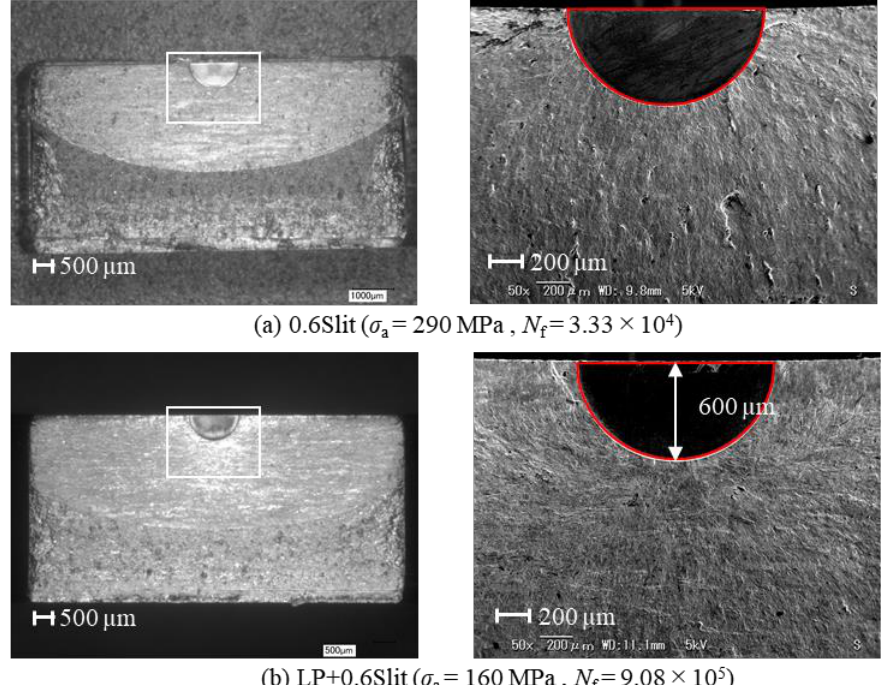
Figure 10. Fracture surface of the ( a ) 0.6 Slit and ( b ) LP + 0.6 Slit specimen.